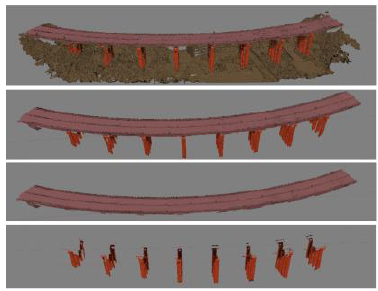
Figure 10. Annunziata Viaduct classified point cloud with deck (pink) and pillar (red)